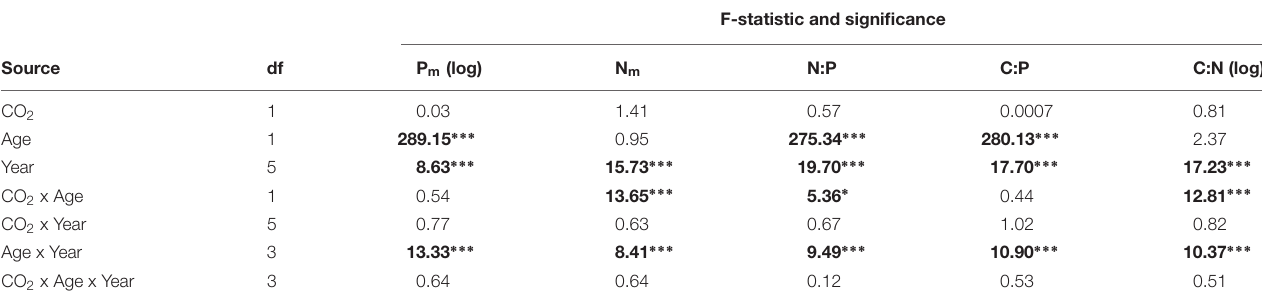
TABLE 1 | Mixed model Anova results with F-statistic of green upper canopy leaves over 5 years with CO 2 , Age and Year as fixed factors and tree nested within ring as random